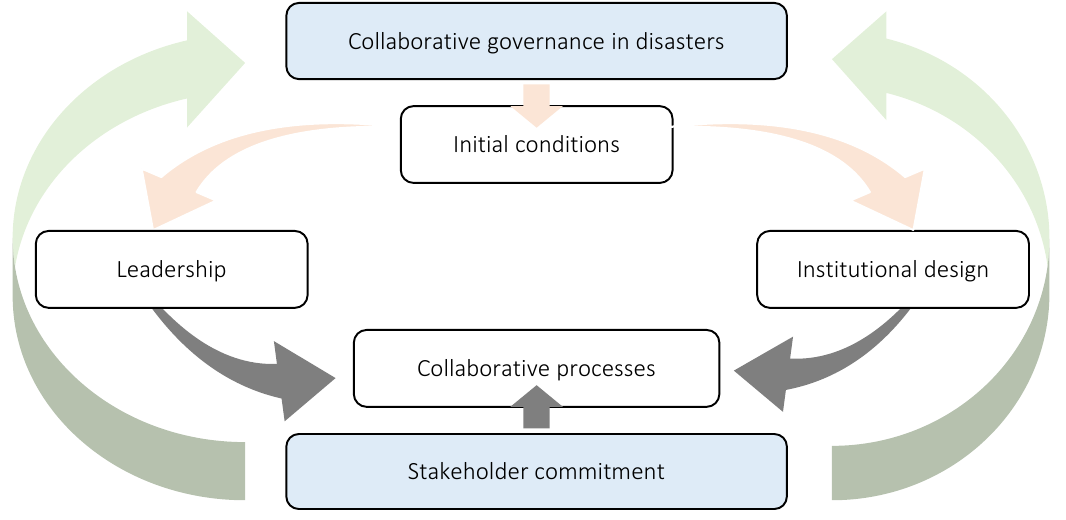
Figure 1. Collaborative governance in